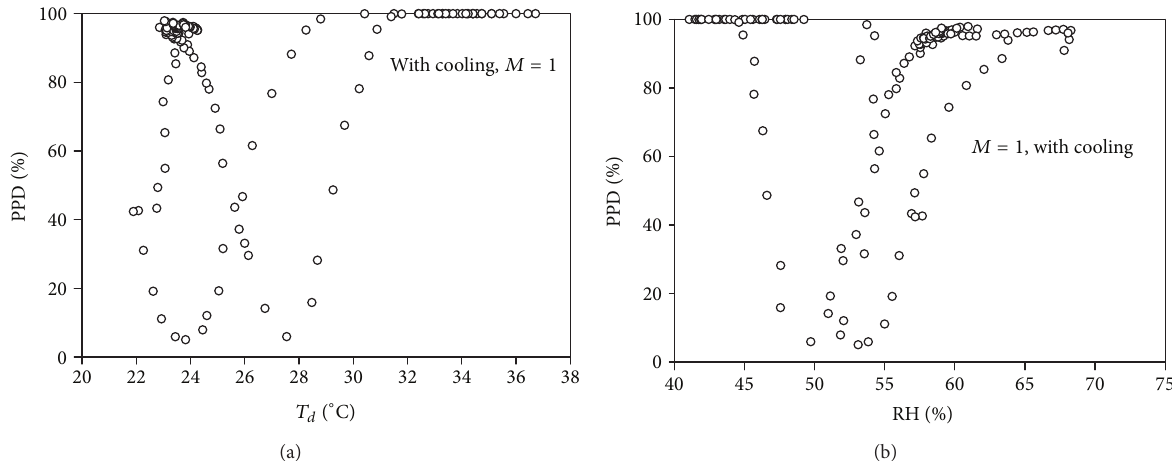
Figure 8: The dry bulb temperature ( 𝑇 𝑑 ) and relative humidity (RH) against the predicted percentage of dissatisfied (PPD) estimated at low or no activity ( 𝑀 = 1 ) in the cooled greenhouse: (a) for 𝑇 𝑑 and (b) for